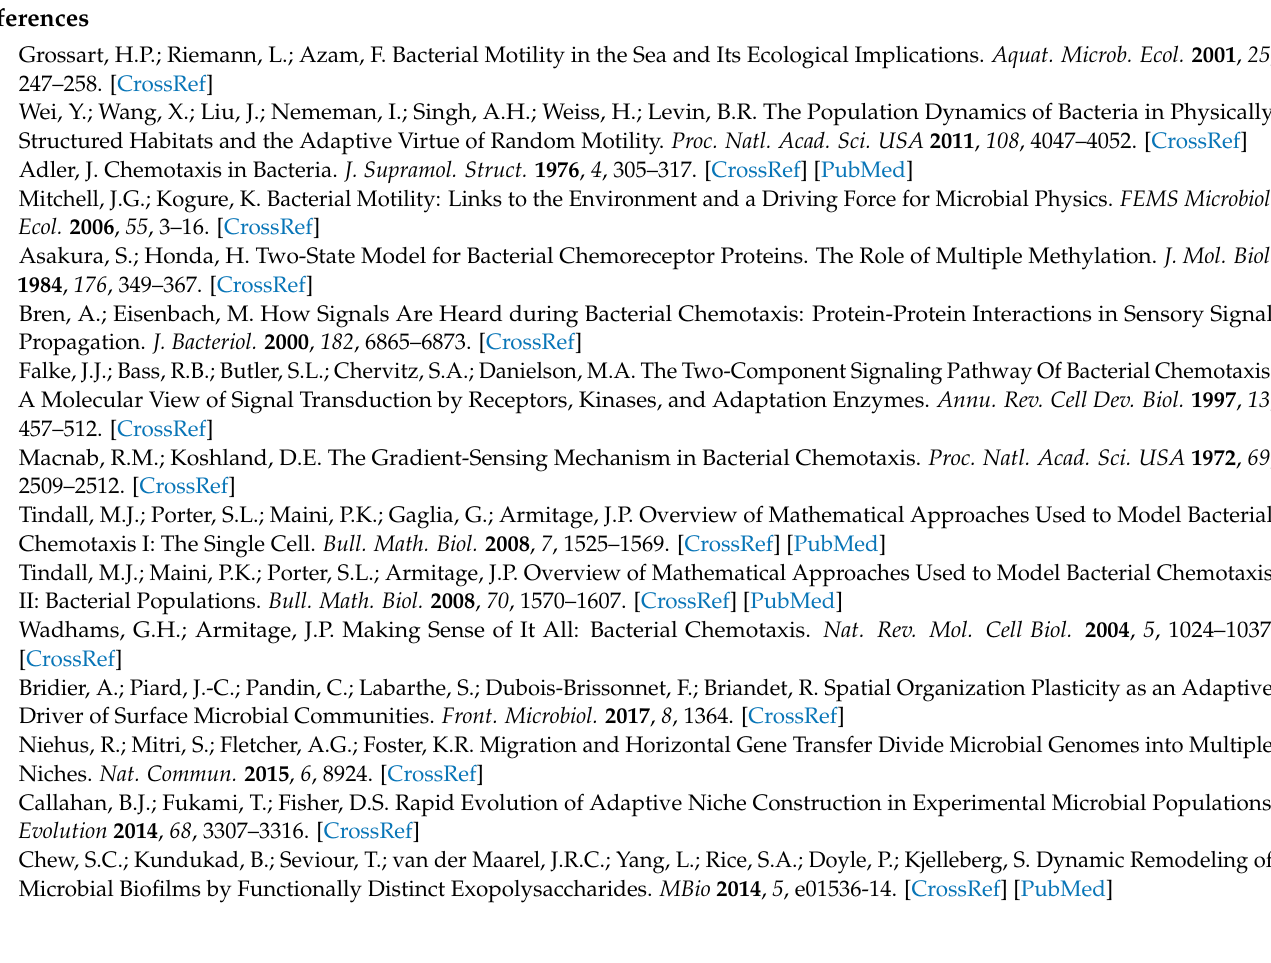
Table S2: All the parameters of the Settler–Nomad model, Document S1: “Haploid evolutionary constructor” modelling approach, and additional